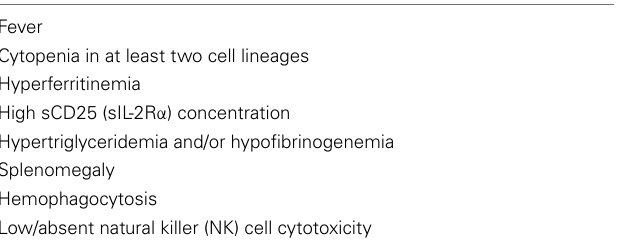
Table 1 | Diagnostic criteria for HLH